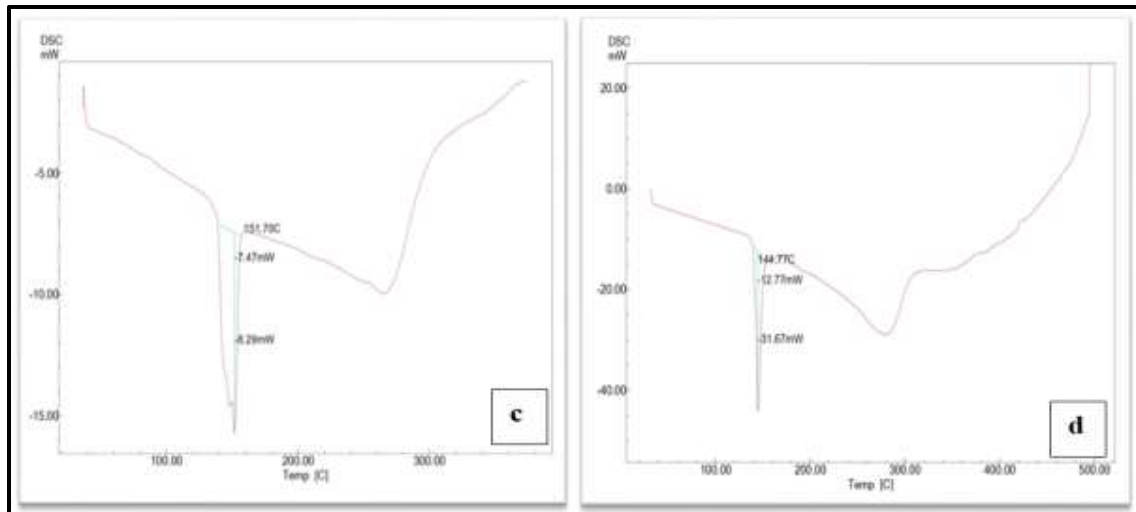
Figure 11. DSC of N3 (c) co-crystals and physical mixture C1 (d). The physical mixture (C1) showed the DSC profile d. Powder x-ray diffraction (PXRD):